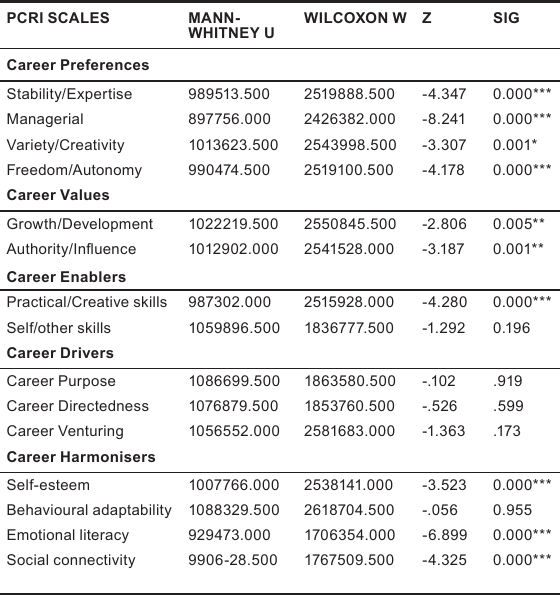
Table 4 Kruskal-Wallis tests: Biographical variables (N = 2